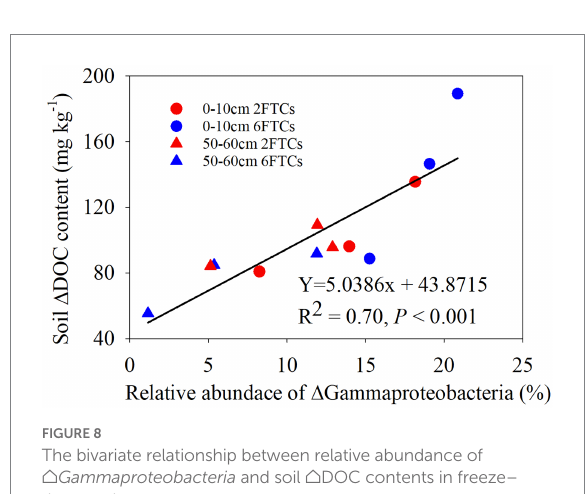
FIGURE 8 The bivariate relationship between relative abundance of ⌂ Gammaproteobacteria and soil ⌂ DOC contents in freeze– thaw